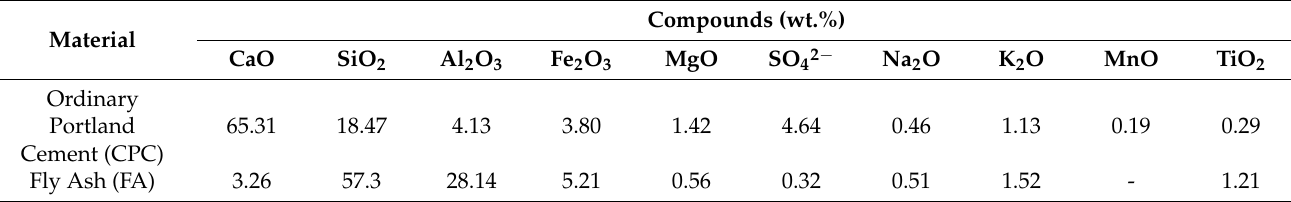
Table 1. Chemical composition of OPC and FA obtained by XRF.